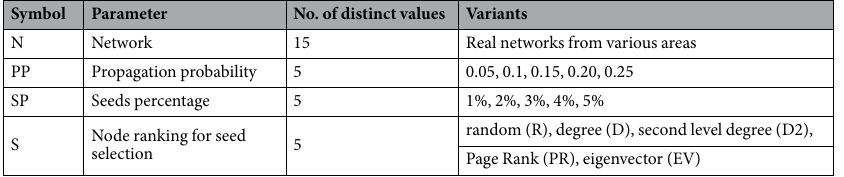
Table 2. Networks and parameters of diffusion used in